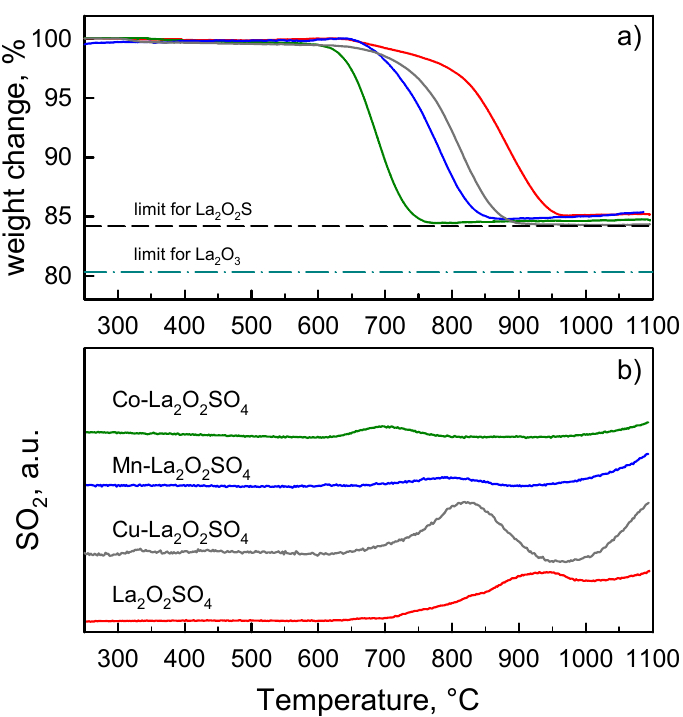
Figure 4. ( a ) TG curves for La 2 O 2 SO 4 and metal (Cu, Mn, Co) promoted La 2 O 2 SO 4 during reduction under a flow of 2% H 2 /N 2 . Heating rate: 10 °C min − 1 ; ( b ) Corresponding MS profiles for SO 2 ( m/z = 64) in the evolved gas.